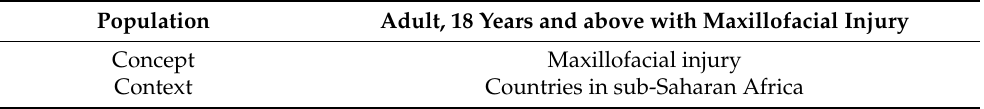
Table 1. PCC framework for defining the eligibility of the studies for the principal research question.